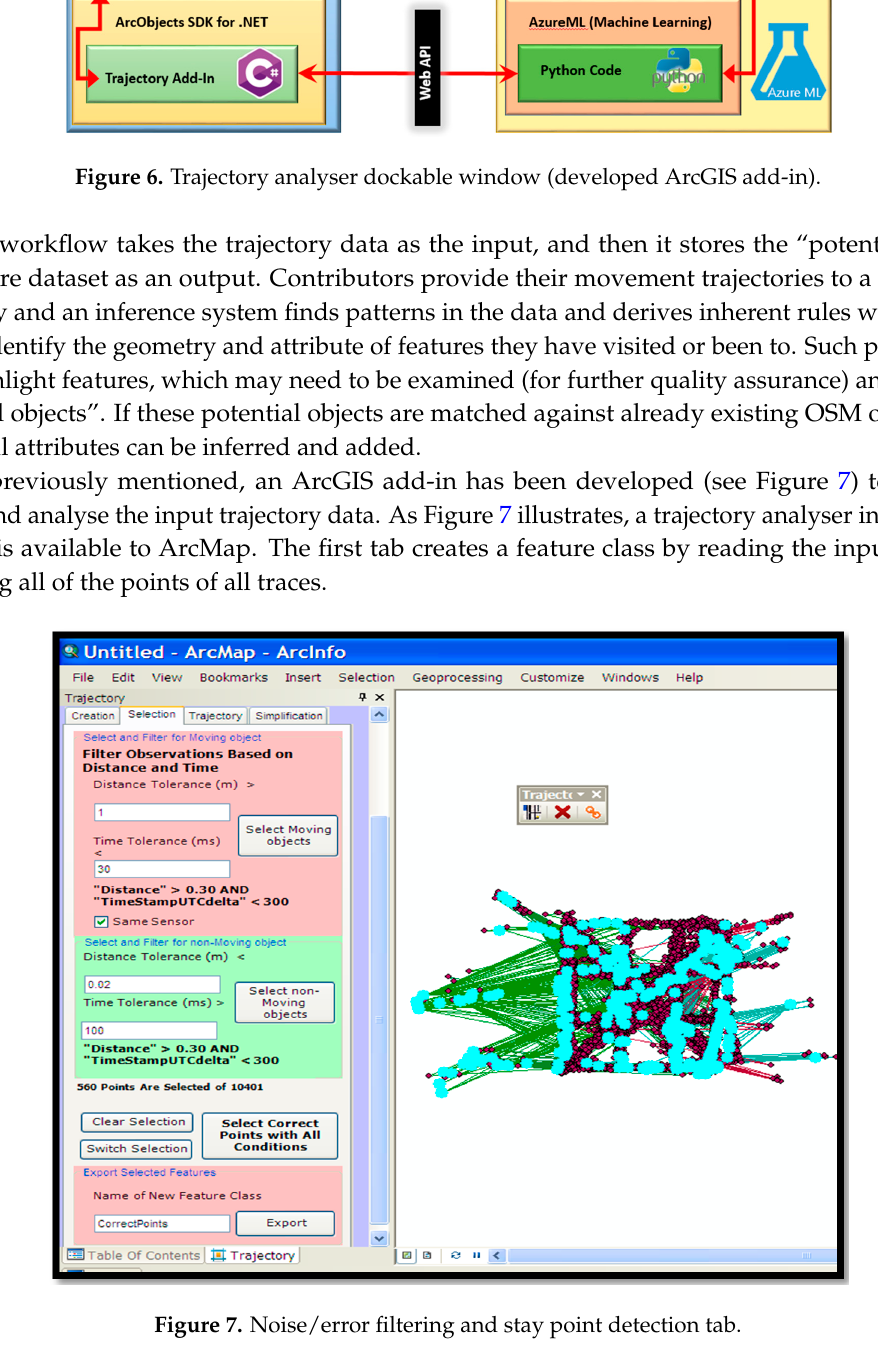
Figure 7. Noise/error filtering and stay point detection tab.